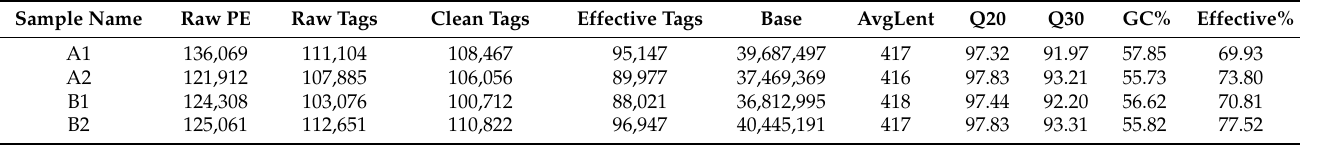
Table 2. Summarization of the tags and OTUs number of each sample (A1, thermophilic of Harmanli site; A2, mesophilic of Harmanli site; B1, mesophilic of Yasno pole site; B2, thermophilic of Yasno pole